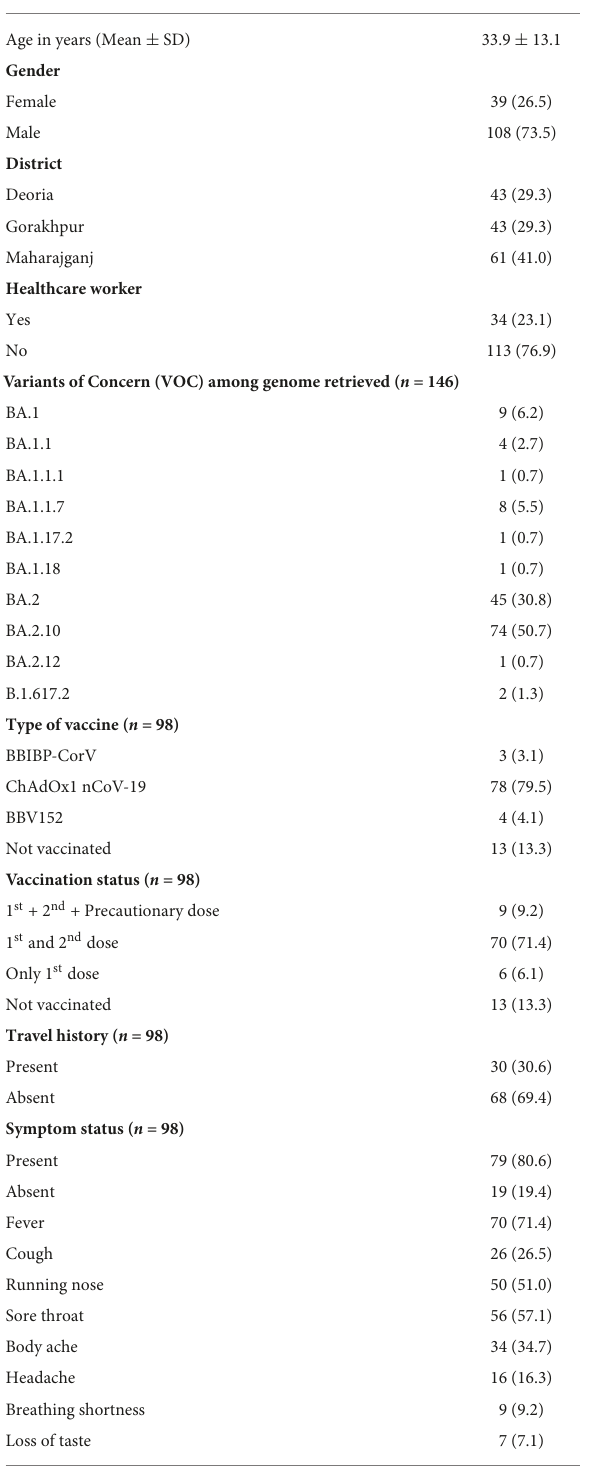
TABLE 1 Sociodemographic, clinical, and genomic characteristics of sequenced severe acute respiratory syndrome coronavirus 2 (SARS-CoV-2)-positive cases during the third wave (01 January–24 February 2022) in eastern Uttar Pradesh (UP) ( N = 147).